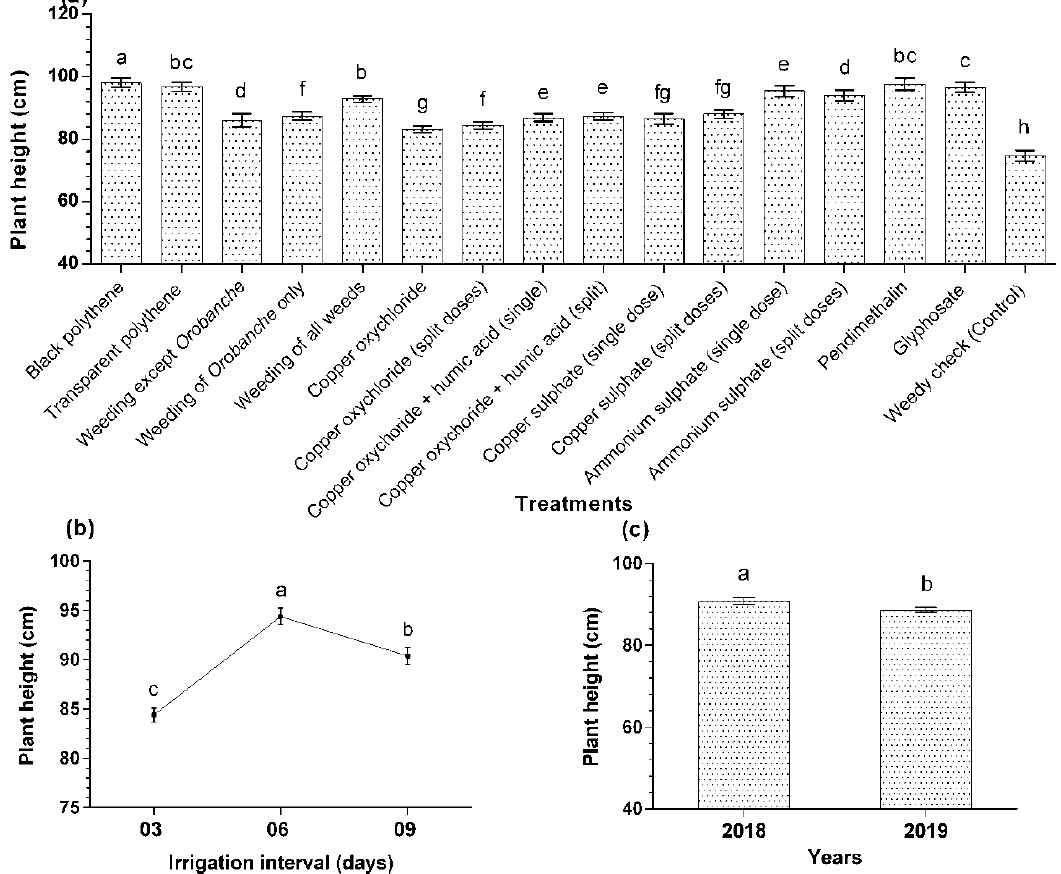
Figure 9. Impact of irrigation intervals and weed management treatments and years on plant height (cm) of tomato. ( a ) Effect of various treatments on plant height of tomato. ( b ) Effect of different irrigation intervals on plant height of tomato. ( c ) Impact of years on plant height of tomato. Based on the Least significant difference test, line and column ± standard error followed by different alphabetical letters are significantly different from each other at a 5% level of probability .